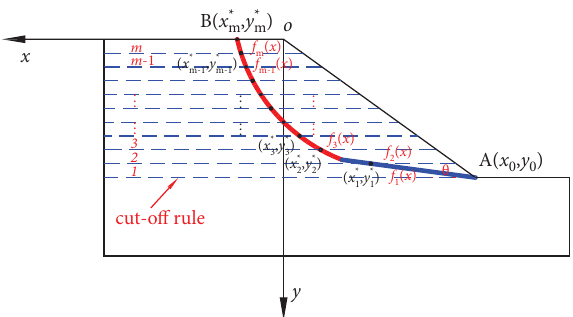
Figure 13: Schematic diagram of sliding surface